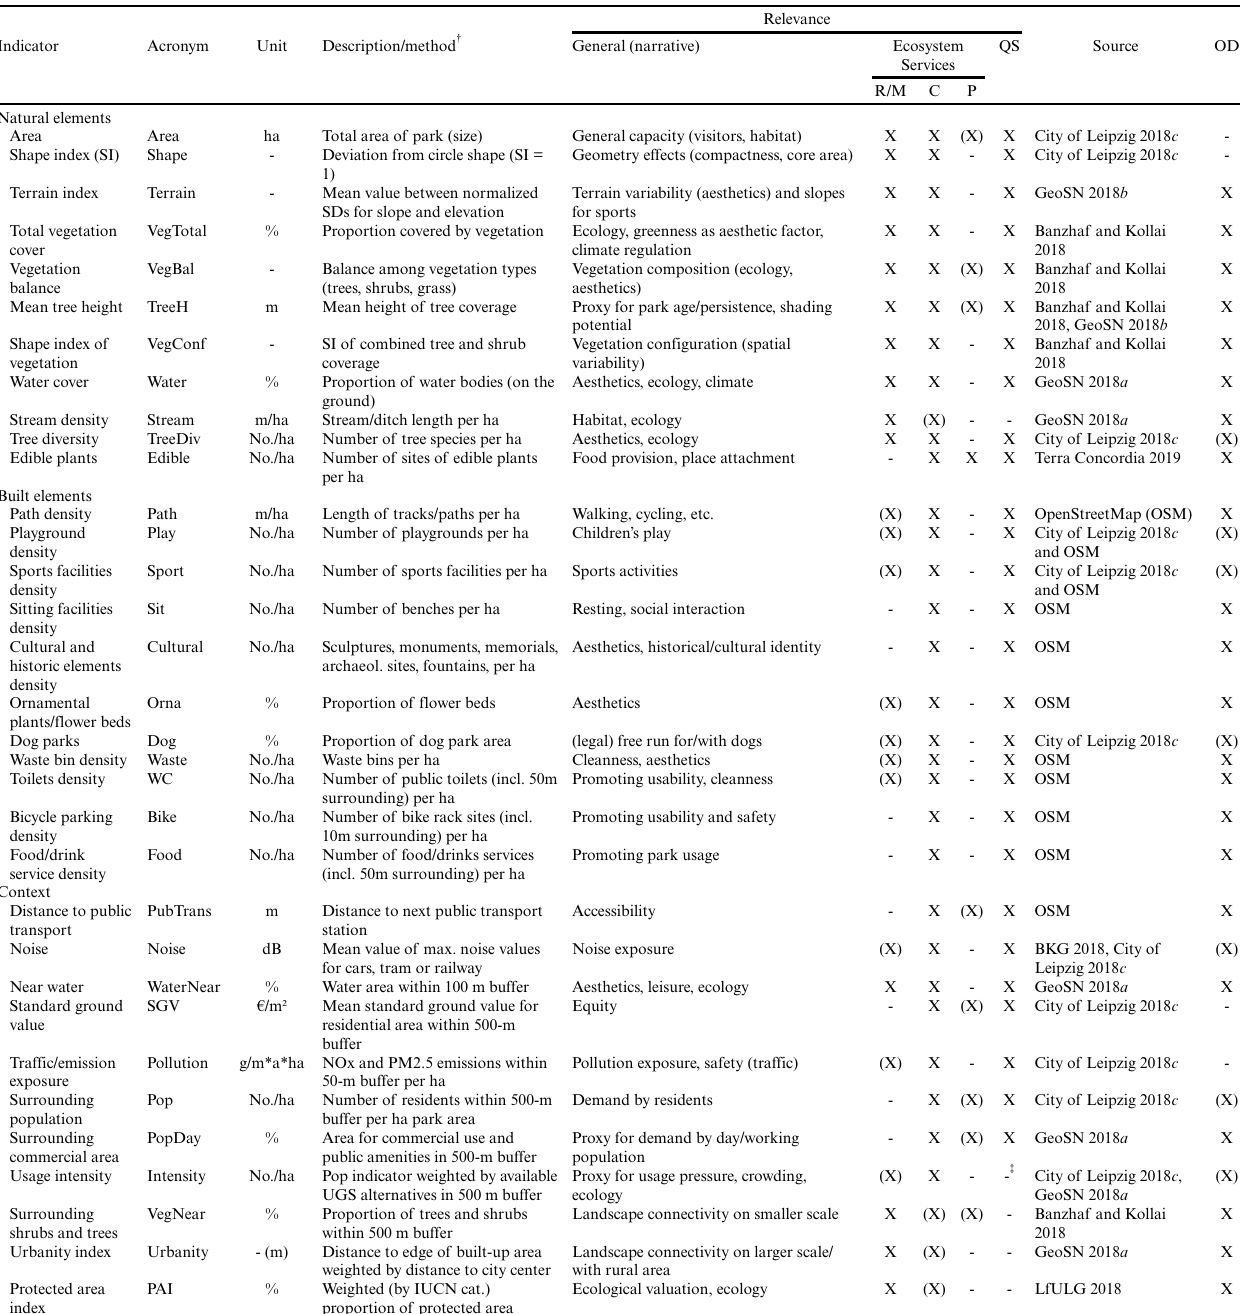
Table 2 . List of indicators per park quality dimension and their characteristics. Cross marks in brackets indicate minor relevance for the respective ecosystem service or data that are only partially open. Acronyms used: R/M = regulation and maintenance, C = cultural, P = provisioning, QS = quality score, OD = open data, SD = standard